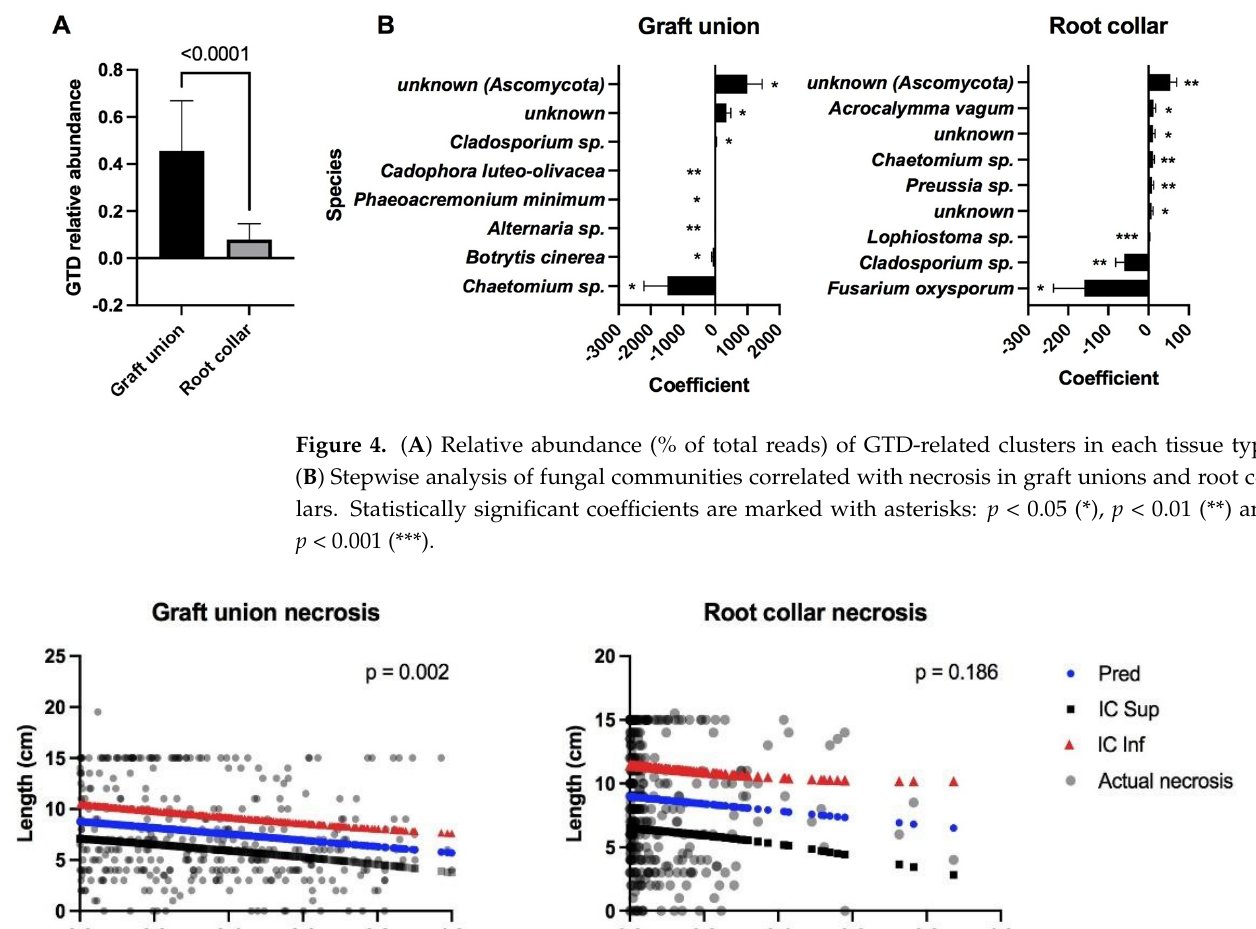
Table 4. Contribution of nursery and storage to the composition of fungal communities including all OTUs (total) and of only OTUs related to GTDs in different varieties and rootstocks. The number in parentheses indicates the number of nurseries the variety or rootstock was present in. Only vari- eties that were present in at least three nurseries are shown. Annotation next to the numbers indi- cates significance level: *** <0.001, ** <0.01, * <0.05, n.s. = not significant (>0.05).